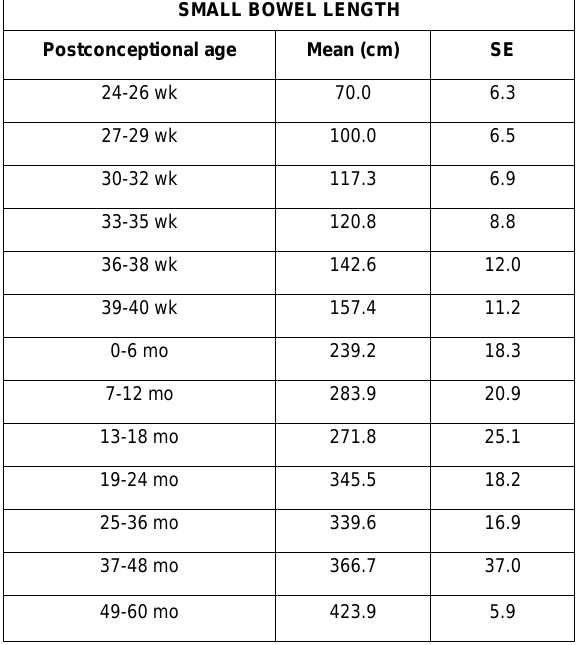
Table 1: Small bowel length and post conceptional age.